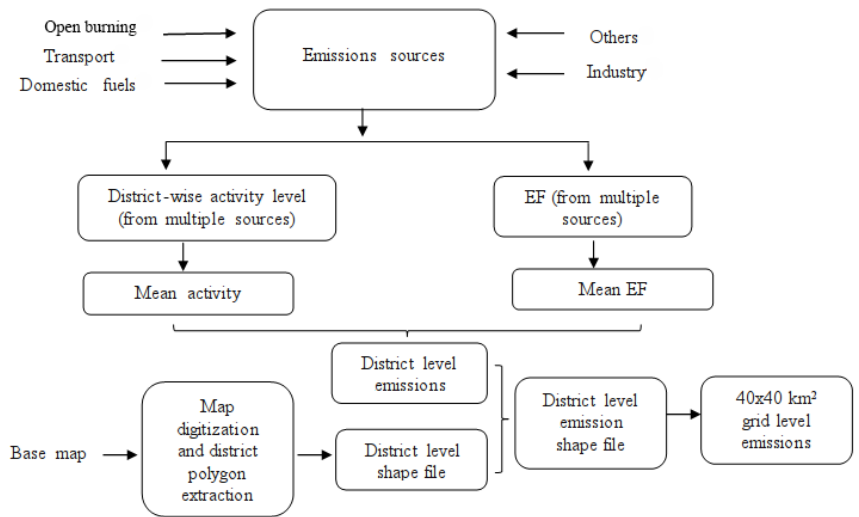
Figure 2. Methodology for preparing gridded